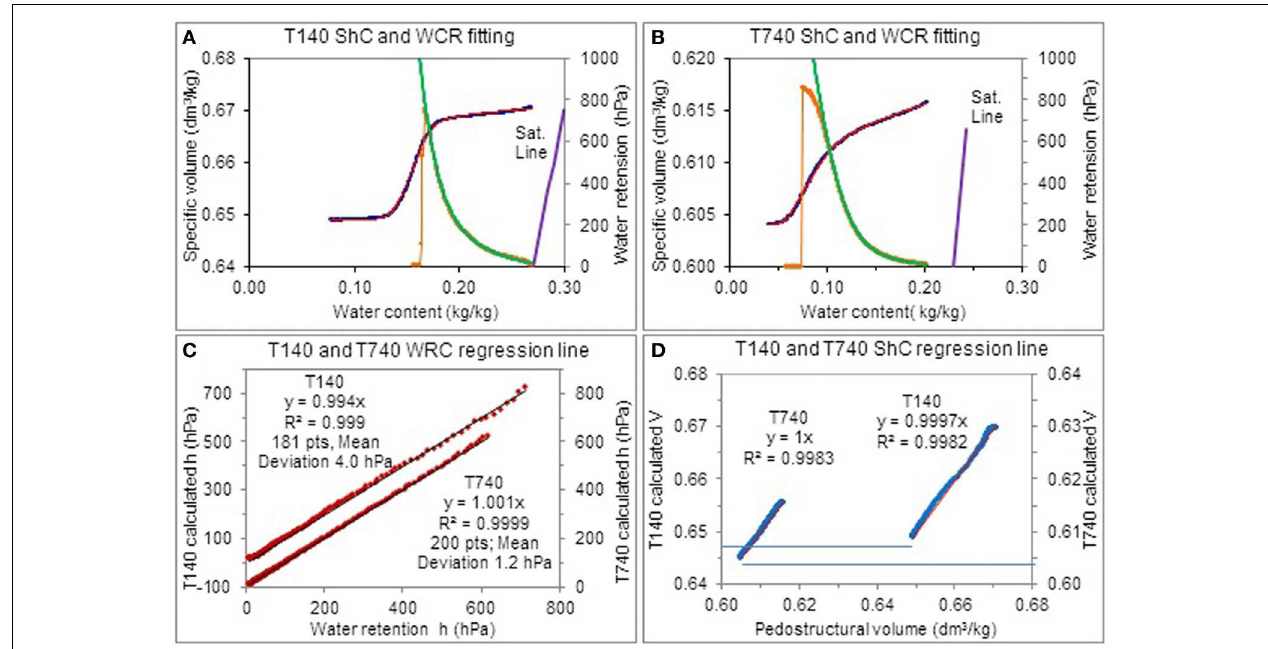
FIGURE 8 | Adjustment of the measured characteristic curves by their theoretical parametric equations for the ferrallitic soil samples T140 and T740. (A,B) Represent for each sample the shrinkage curve (ShC), measured (blue points) and calculated (red line) with its associated water